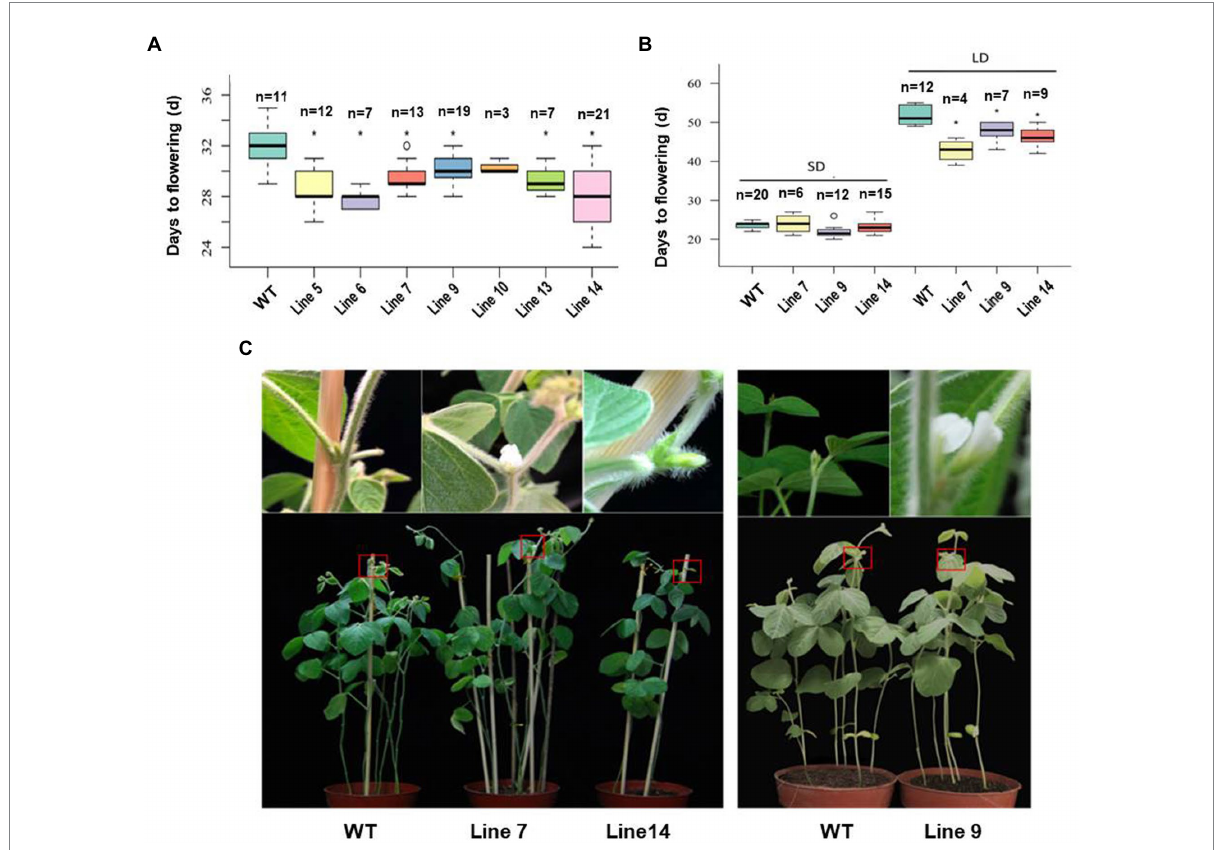
FIGURE 3 The flowering time of the transgenic GmFT3a soybean in natural (A) and long-day (LD) and short-day (SD) (B) conditions and the flowering phenotypes of transgenic GmFT3a T 2 generation in LD condition (C) . The seeds sown in Beijing, China (N39 ° 58 ′ , E116 ° 20 ′ ) on June 20, 2018. The data represent the mean ± standard deviation, and statistical significance was determined using Student’s t -tests (* p < 0.05, ** p < 0.01). DAE: days after